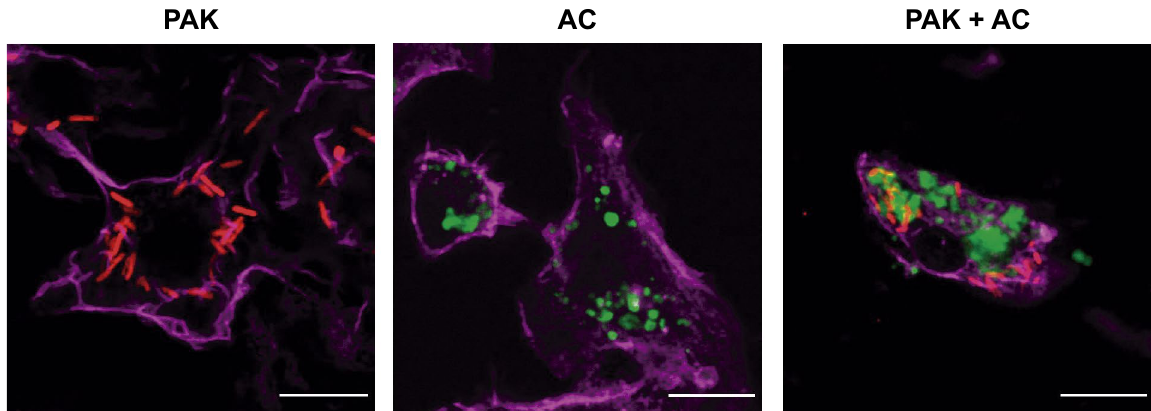
Figure 1. P. aeruginosa adheres to J774 apoptotic cells and both are internalized by macrophages. Projected confocal Z-stacks of BMDM exposed for 30 min to bacteria, apoptotic cells, or both. Scale bars 10 µm. Green: CFSE-labeled J774 apoptotic cells. Red: PAK-mCherry. Magenta: